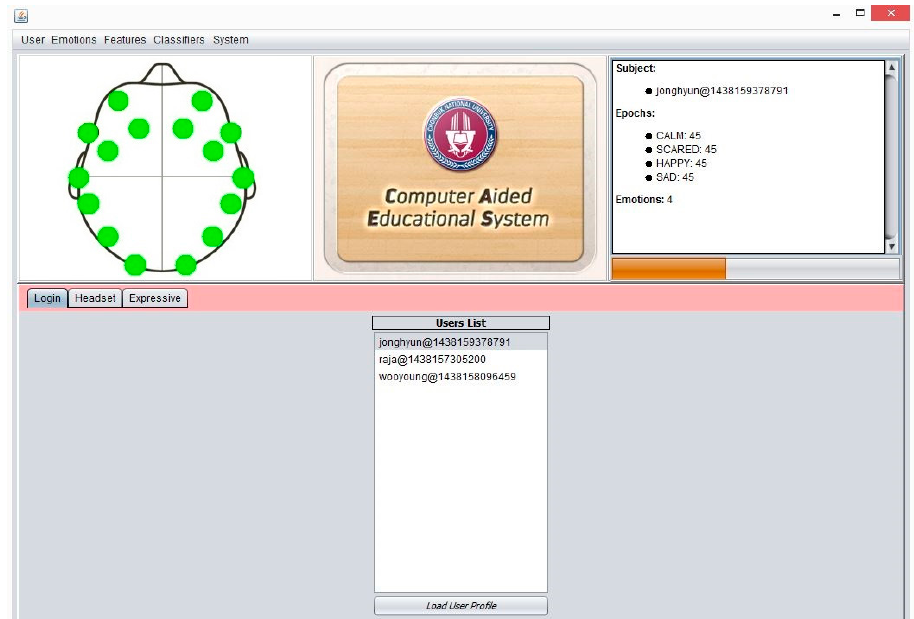
Figure 13. CAES (User Login); it provides the facility for users logging into the system. At this point the user can see the signal quality of the Emotiv headset channels, and the user can see the current user details such as name, epochs, etc. Sensors 2017 , 17 , 317